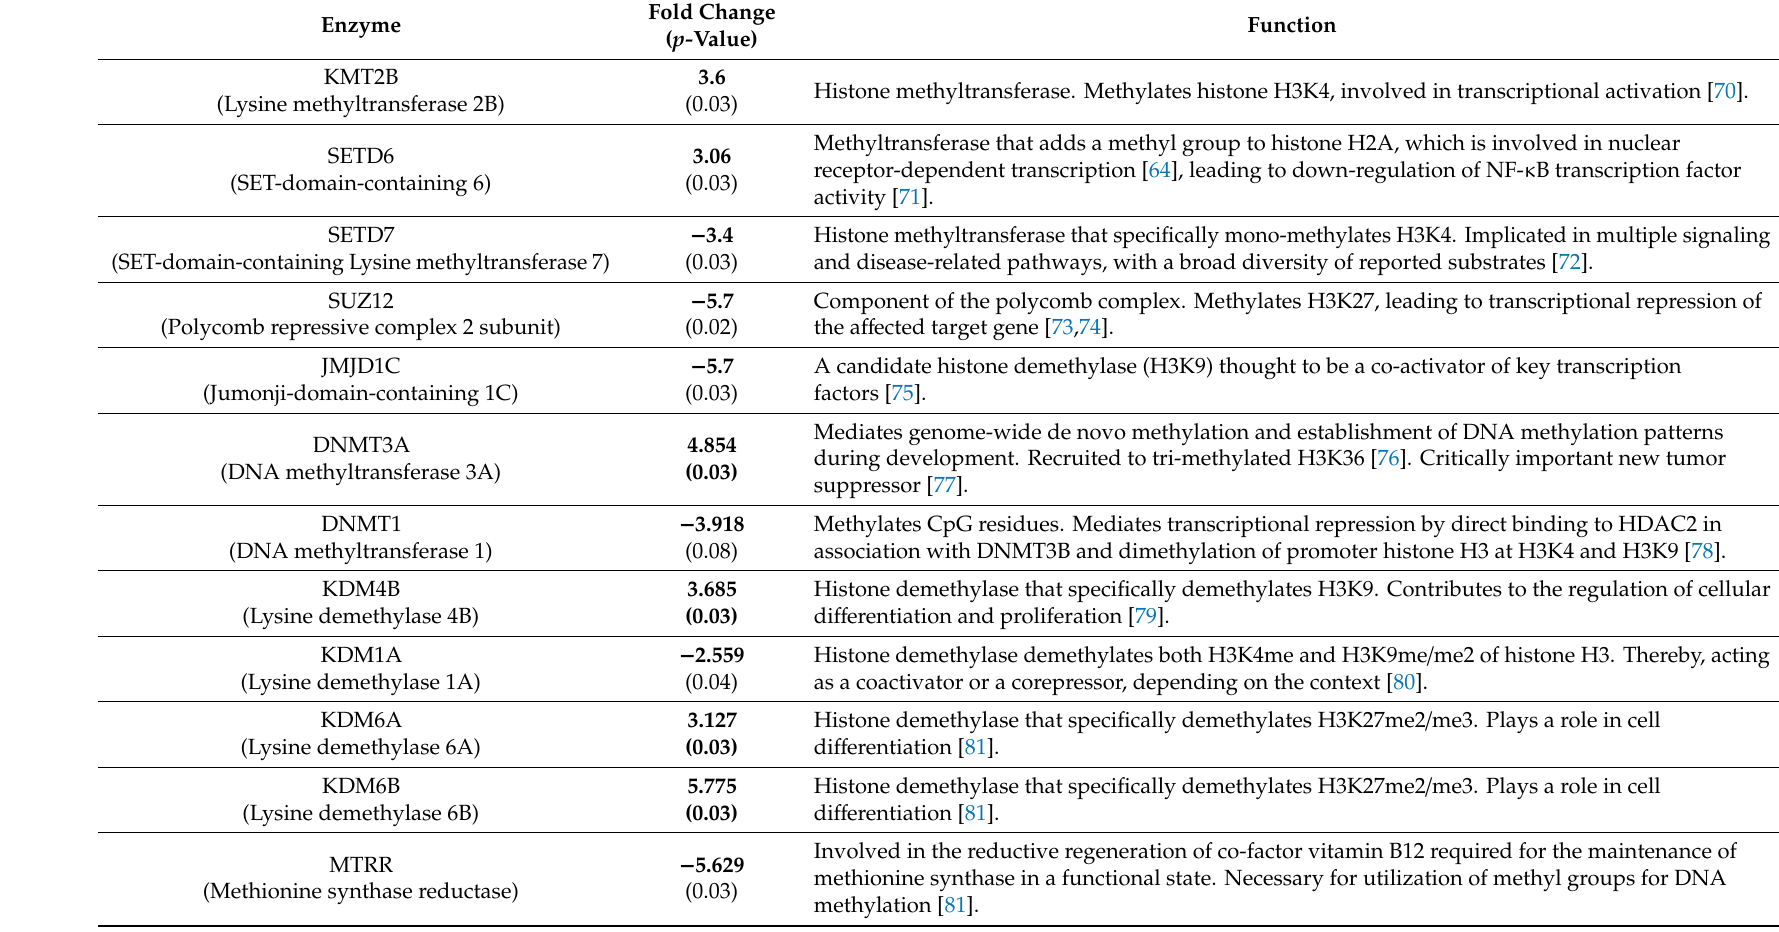
Table 2. si-VDAC1 alters the expression of epigenetics-processes-related enzymes associated with methylation. Results are from DNA-microarray analysis and represent the fold change in expression in si-hVDAC1-TTs, relative to the levels in si-NT-TTs. Selected genes associated with epigenetics are presented. Genes modified ≥ 2-fold with a false discovery rate < 0.05 are listed. For each gene, the gene symbol and name, linear fold change in expression, and p -value are as indicated. Negative numbers represent